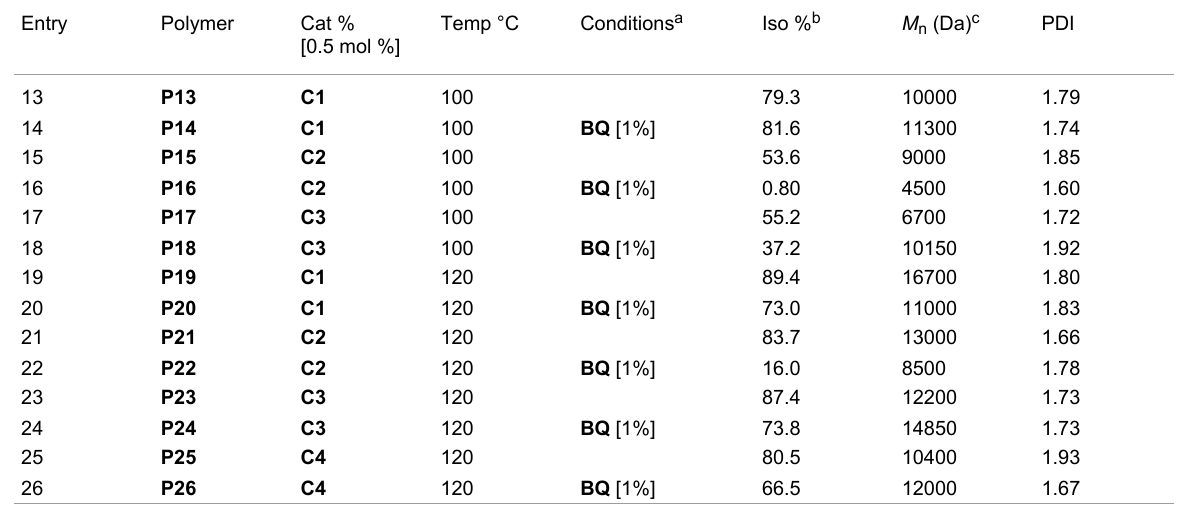
Table 2: Overview of polymerization and the isomerization results of the corresponding polymers obtained at 100 and 120 °C after 5 h reaction time.